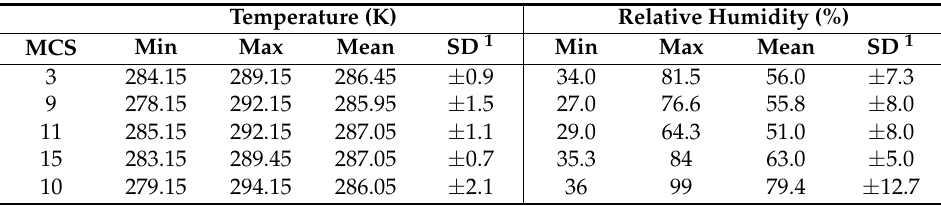
Table 1. Statistical summary of temperature and relative humidity statistics inside (MCSs 3, 9, 11, 15) and outside (MCS 10) the